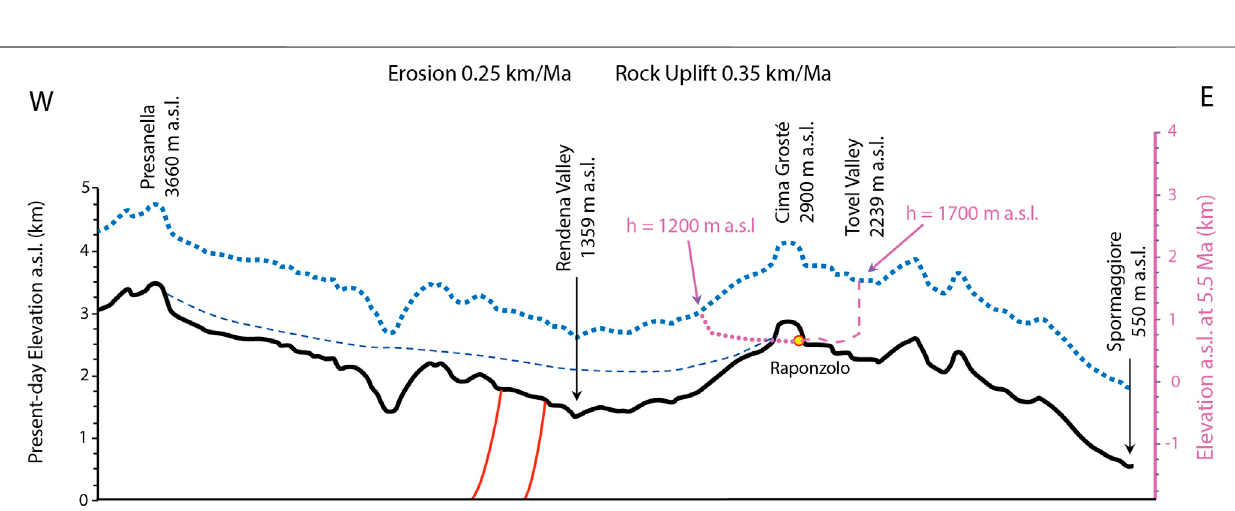
Frontiers in Earth Science |